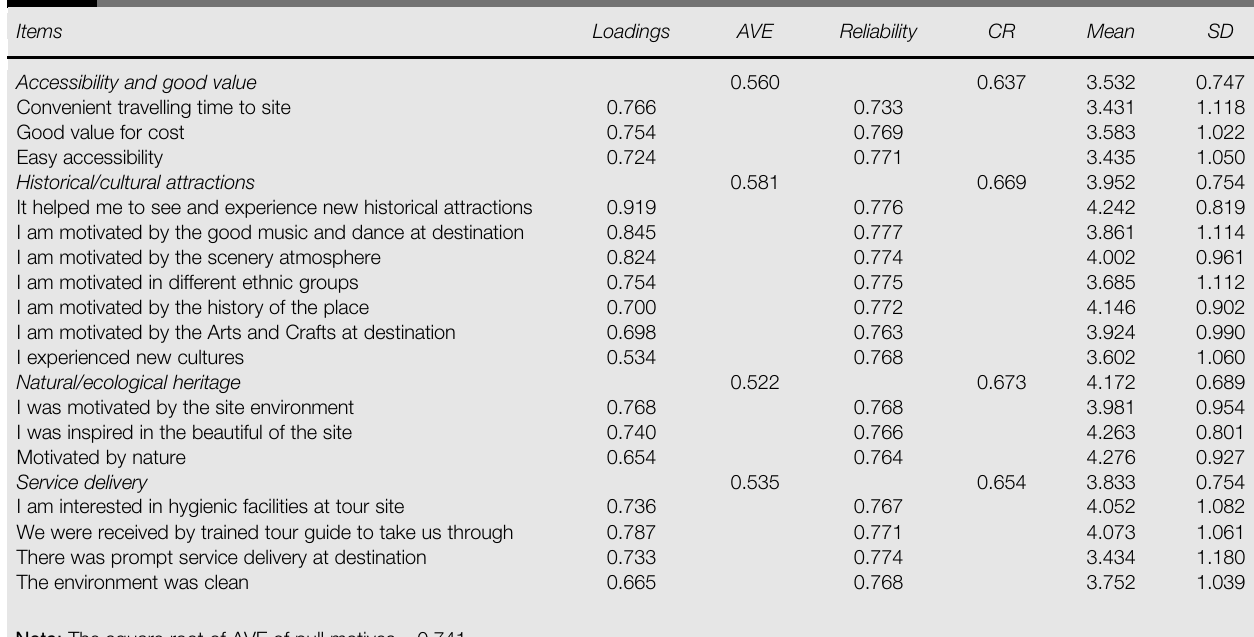
Table II Factor analysis of pull motives of youth tourism Items Loadings AVE Reliability CR